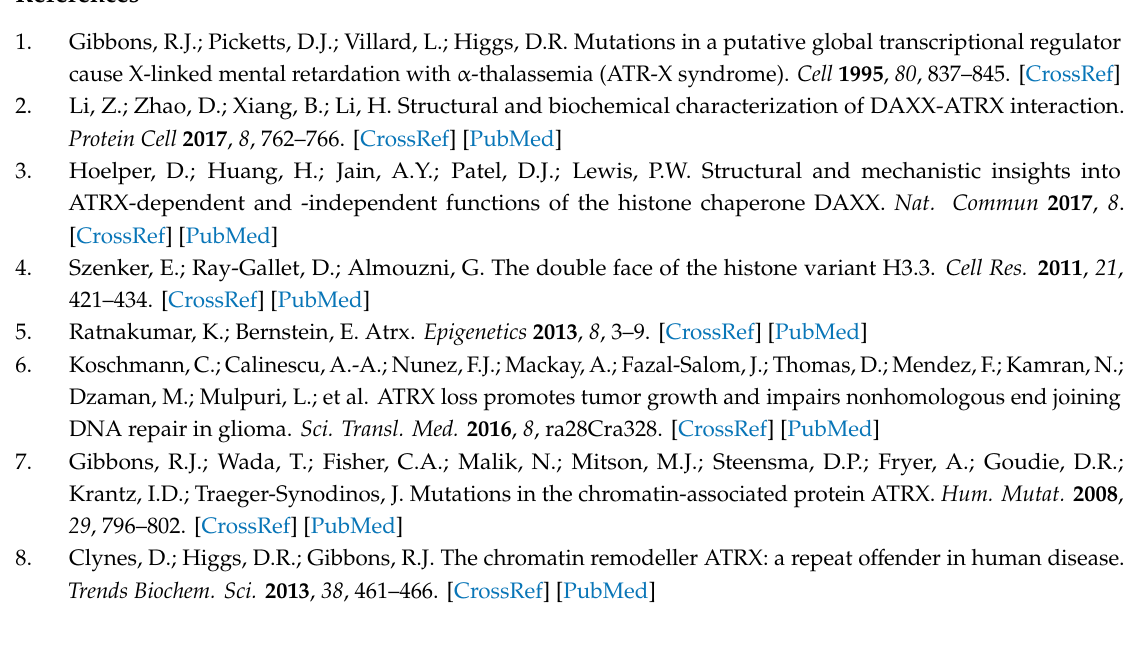
Figure S1: Binding a ffi nities for H3 1-15 peptides bound to ATRX ADD as determined by microscale thermophoresis (MST), Table S1: Parallel Fluorescence Intensity Signals from FP Optimization, Figure S2: Assay window from FP optimization studies, Table S2: Relative Luminescence Values from AlphaScreen Optimization, Figure S3: Assay window from AlphaScreen optimization studies, Figure S4: Disruption of the ATRX ADD :H3 PPI under various conditions through the AlphaScreen assay, Figure S5: Schematic of workflow for virtual screening using Schrodinger Glide, Figure S6: Modeling of H3 peptides into the ATRX ADD, Table S3: Amino acid sequences for peptides utilized in the FP and AlphaScreen optimization, Table S4: Results for Ni-His AlphaScreen Bu ff er Optimization, Table S5: Virtual Screening Predicted Hits for Grid A (ART), Table S6: Virtual Screening Predicted Hits for Grid B